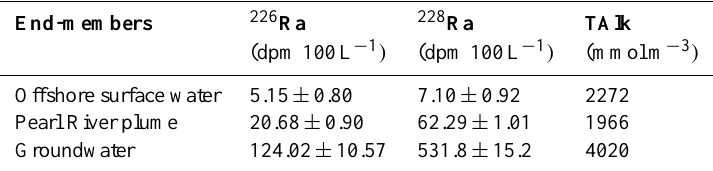
Fig. 7. Total alkalinity (TAlk) versus 228 Ra (a) and 226 Ra (b) in the surface water of the northern South China Sea excluding the nearshore upwelling zone. Surface water samples were taken from 30 June–8 July, 2008. Subsurface end-member values for 228 Ra and 226 Ra activity were based on the measurements at 150m depth in the same region from a cruise conducted in April, 2009. Also shown are the individual end-member values for the three end-member mixing model (c and d) . The average groundwater (GW) end-member values for 228 Ra and 226 Ra were sampled in December 2008 and October 2010, respectively. Red circles represent the surface data, and the error bars are associated analytical errors. Black circles represent end-member values for river plume, offshore subsurface water, offshore surface water, and average GW, where the error bars reflect the spatial variation ( ± 1 σ) . Table 2. End-member values used for 226 Ra-TAlk and 228 Ra-TAlk three end-member mixing model to estimate submarine groundwater discharge flux to the northern South China